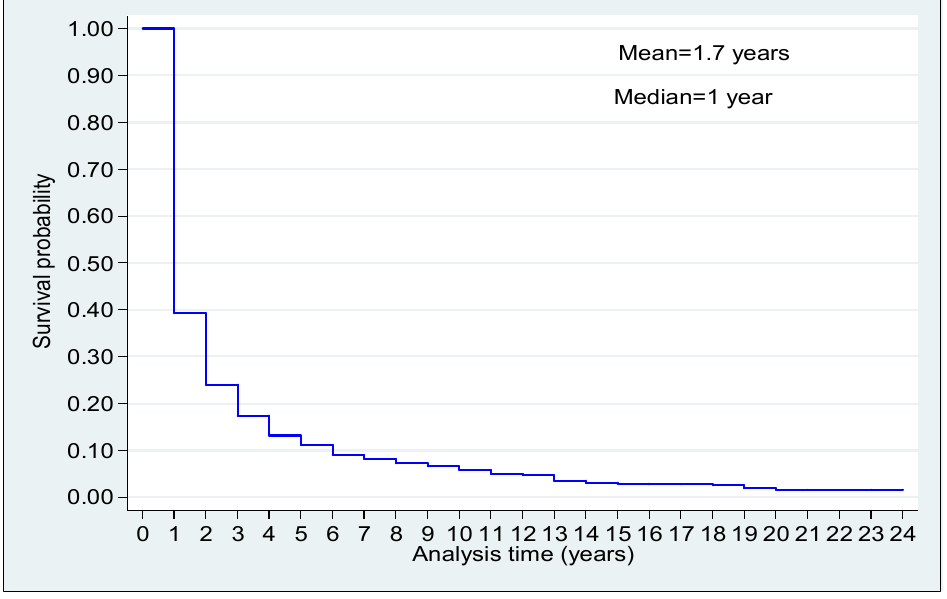
Figure 1. Export duration of total agricultural products. Source: Author′s computation (2020).